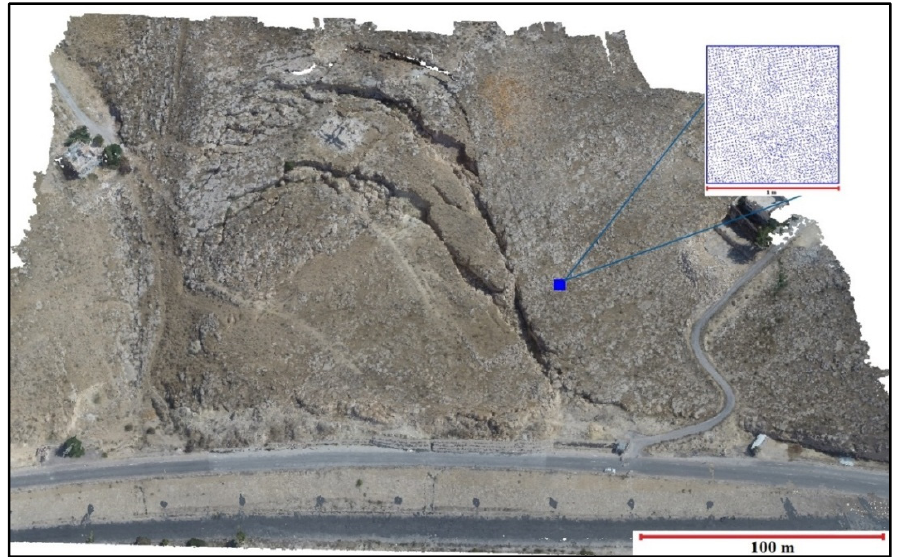
Figure 12. The dense 3D point cloud generated from the UAV image dataset collected in September 2014. The blue inset square represents the point density within 1 m 2 .